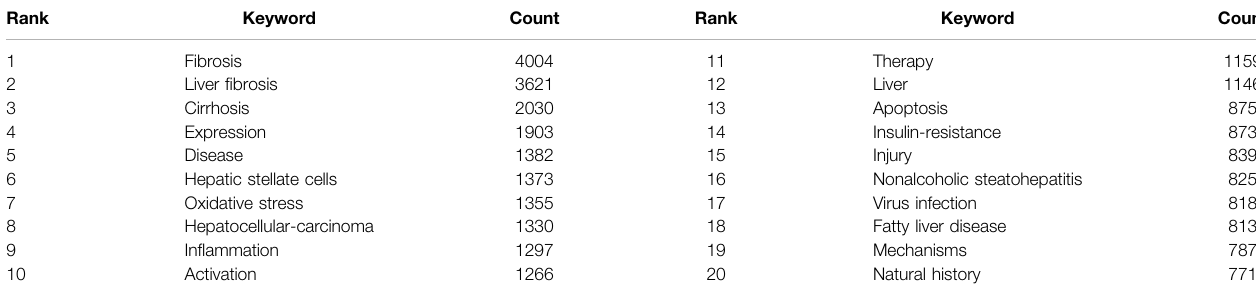
TABLE 4 | The top 20 keywords associated with the treatment of liver fi